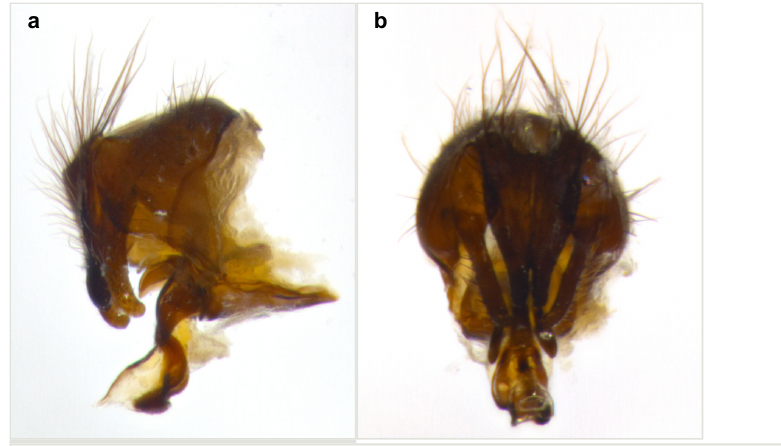
c Figure 25. Male terminalia of Calolydella nigripalpis sp. n. ; a–c : paratype, voucher n. DHJPAR0017811. a : lateral view b : dorsal view c : sternite 5 in ventral Female : not known at this time. Diagnosis Calolydella nigripalpis can be distinguished from all other species of Calolydella by the following combination of characters: frontal setae not extending beyond base of postpedicel, palps black in male, four barely visible thoracic vittae, anatergite bare, and abdominal ground color black. Etymology The specific epithet is derived from the Latin adjective " nigrum ", meaning black, and " palpus ", meaning palp, in reference to the black palpi of males of this species. Distribution